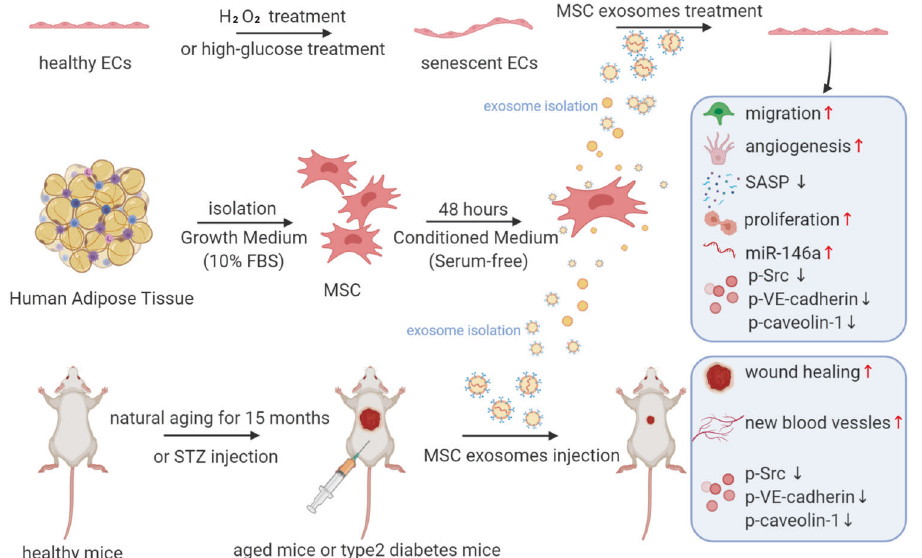
Fig. 7 Schematic illustrations of MSC-sEV repairments on oxidative stress-induced senescence ECs in vitro and in vivo via regulation of the miR-146a/Src pathway (Created with